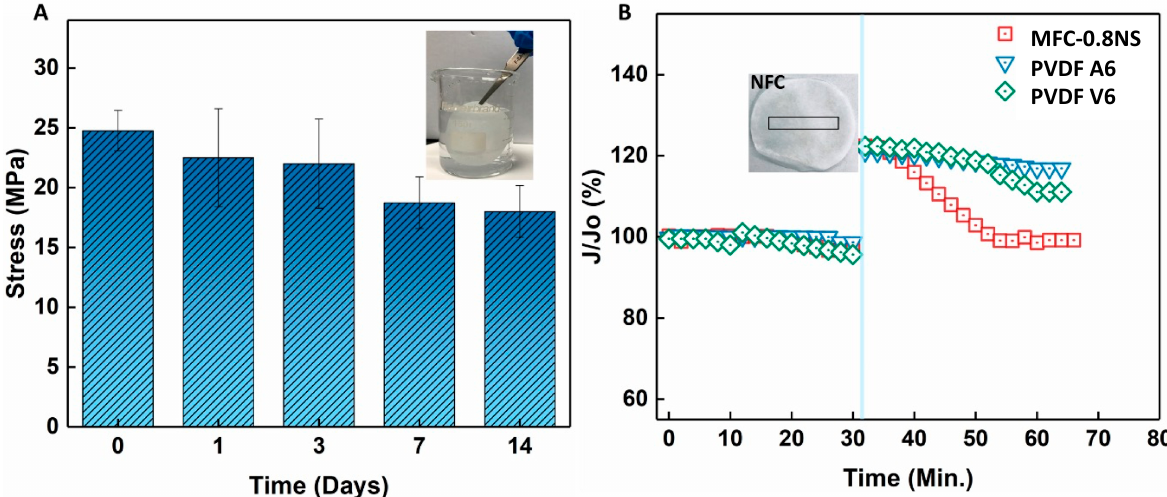
Figure 15. ( A ) Mechanical strength test of the MFC-0.8NS membrane after prolonged immersion in water and ( B ) self-healing property of the MFC-0.8NS membrane.